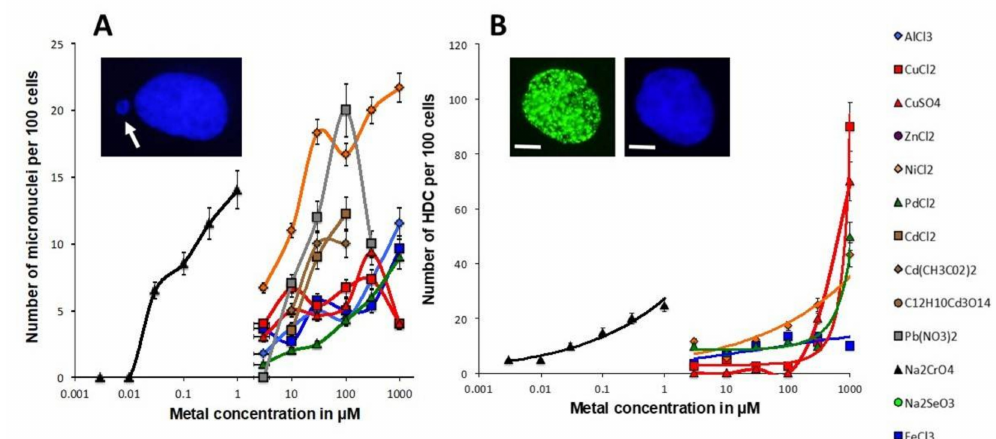
Figure 2. Residual micronuclei and highly damaged cells after metal exposure. ( A ) Number of micronuclei per 100 cells in the human untransformed radioresistant 149BR cells after incubation for 24 h with the indicated concentration of metal species. Each plot represents the mean ± standard error (SEM) of at least three replicates. Insert: Representative example of one micronucleus (white arrow). ( B ) Number of HDC per 100 cells in the human untransformed radioresistant 149BR cells after incubation for 24 h with the indicated concentration of metal species. Each plot represents the mean ± standard error (SEM) of at least three replicates. Insert: Representative example of one HDC stained with anti- γ H2AX antibody and counterstained with DAPI. The white bar represents 5 µ